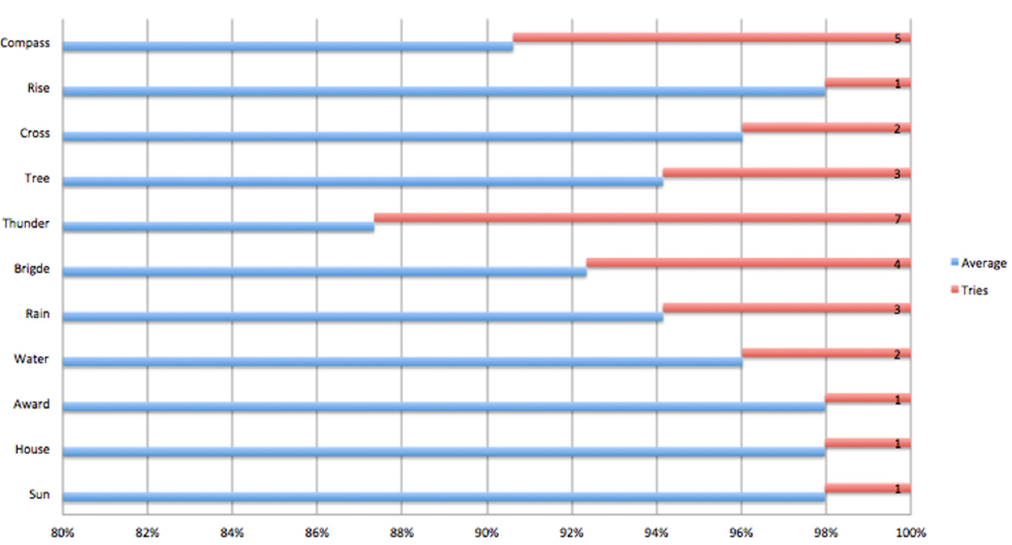
Figure 10. Evaluating PHONOMAGIC in the INCSVC.